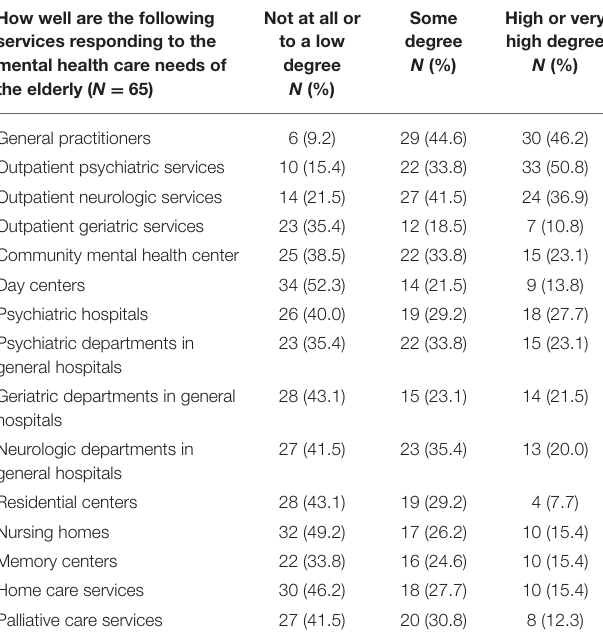
TABLE 1 | General practitioner (GP) characteristics and aspects of their practice and interprofessional collaboration. Demographic data ( N = 65)